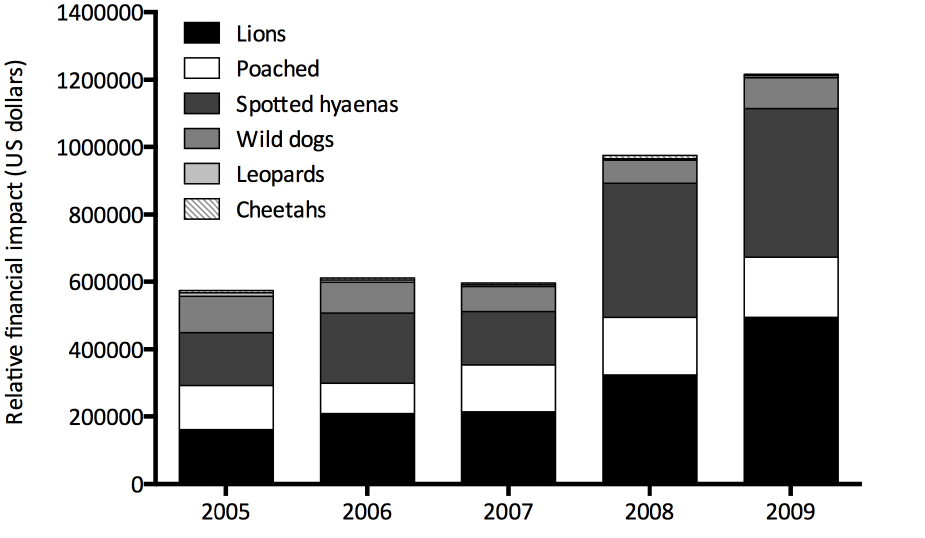
Figure 3. Stacked bar graph depicting the proportional economic losses in US dollars lost in the SVC to the five main predators and poaching from 2005 to 2009.